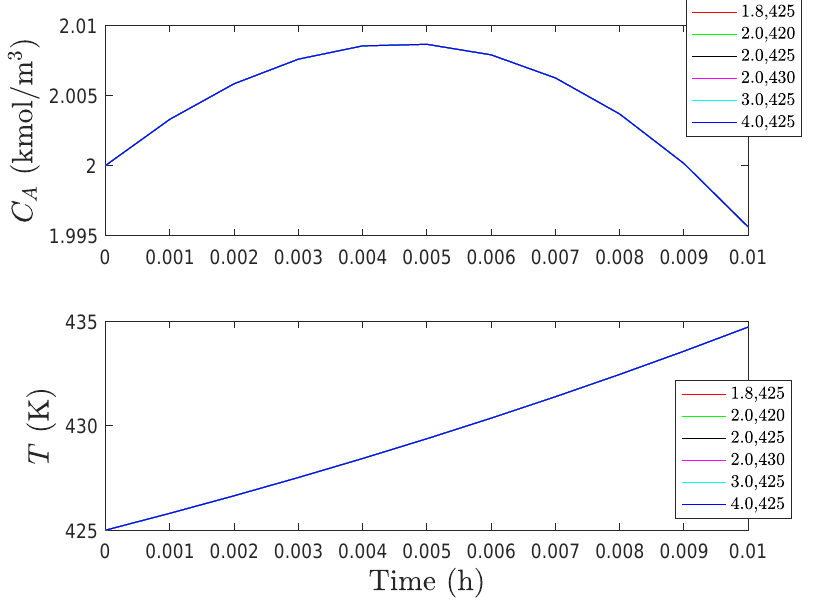
Figure 11. Trajectories of C A and T for one sampling period for various cyberattack scenarios. The trajectories are overlapping.